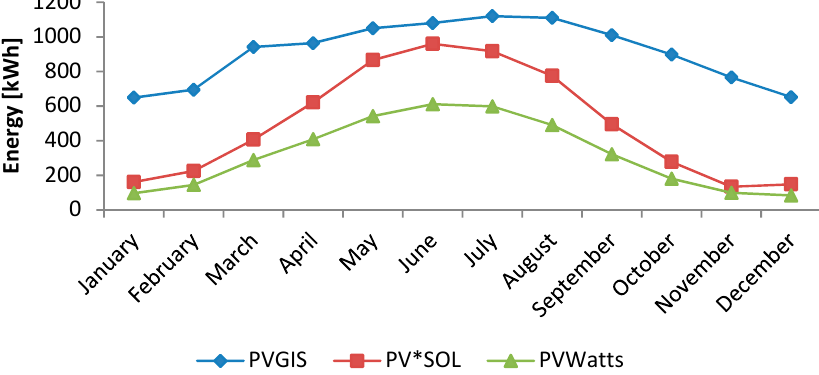
Figure 14. Monthly variation of energy generation for Gazima˘gusa.